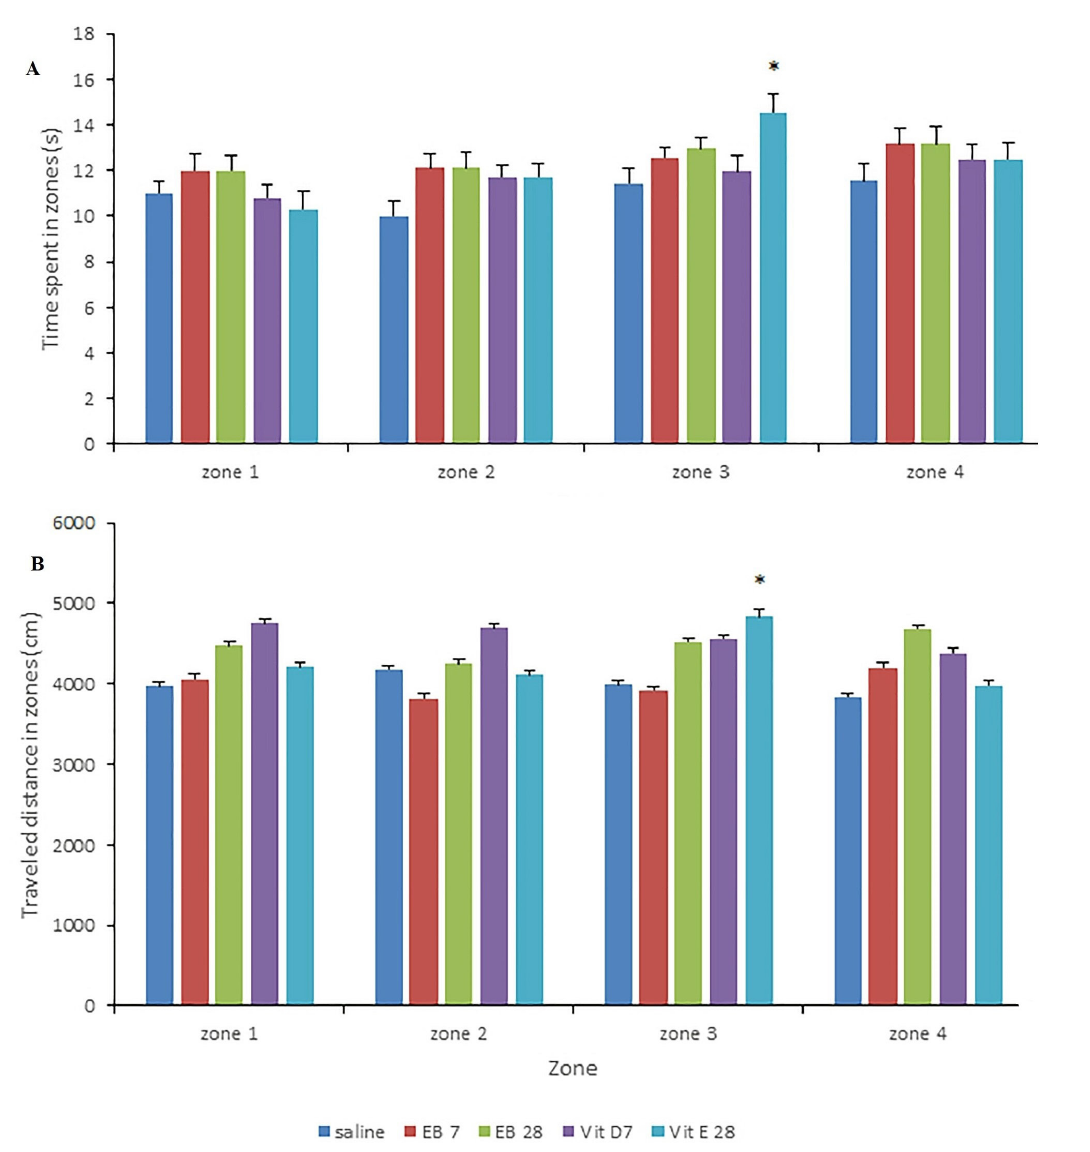
FIGURE 2 - Effect of vitamin D on the travelled distance and time spent in the four virtual quadrants to reach the platform in 3 MWM experiments. Each data is average of 10 experiments and bars represent standard errors. Zone 3 is the target zone in which the platform is